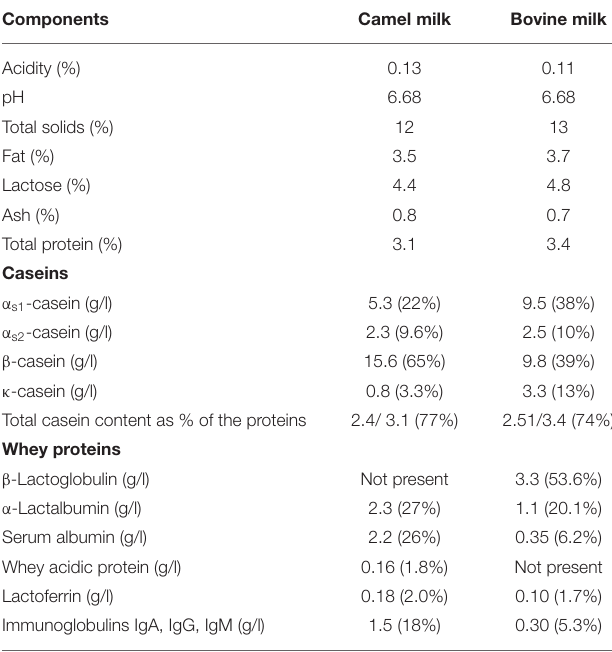
TABLE 2 | Average pH/acidity, content of major constituents, and protein composition of camel and bovine milks*. Components Camel